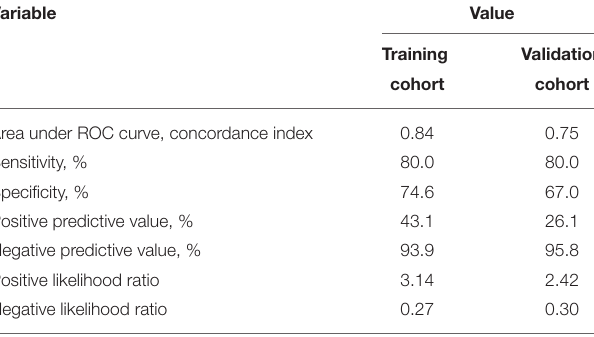
TABLE 3 | Accuracy of the prediction score of the nomogram.